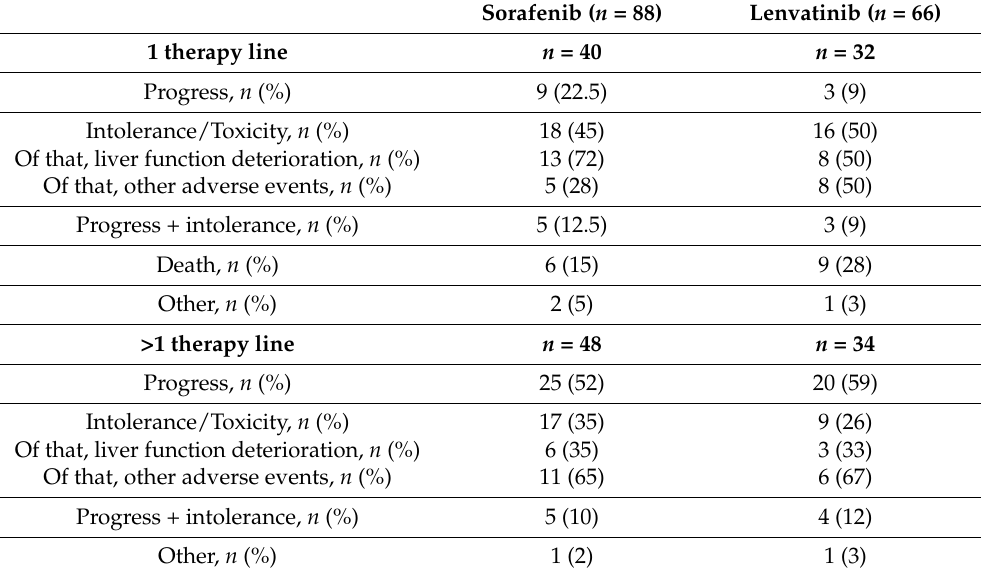
Table 2. Reasons for discontinuation of first-line therapy, sorafenib-based first-line therapy vs. lenvatinib-based first-line therapy.